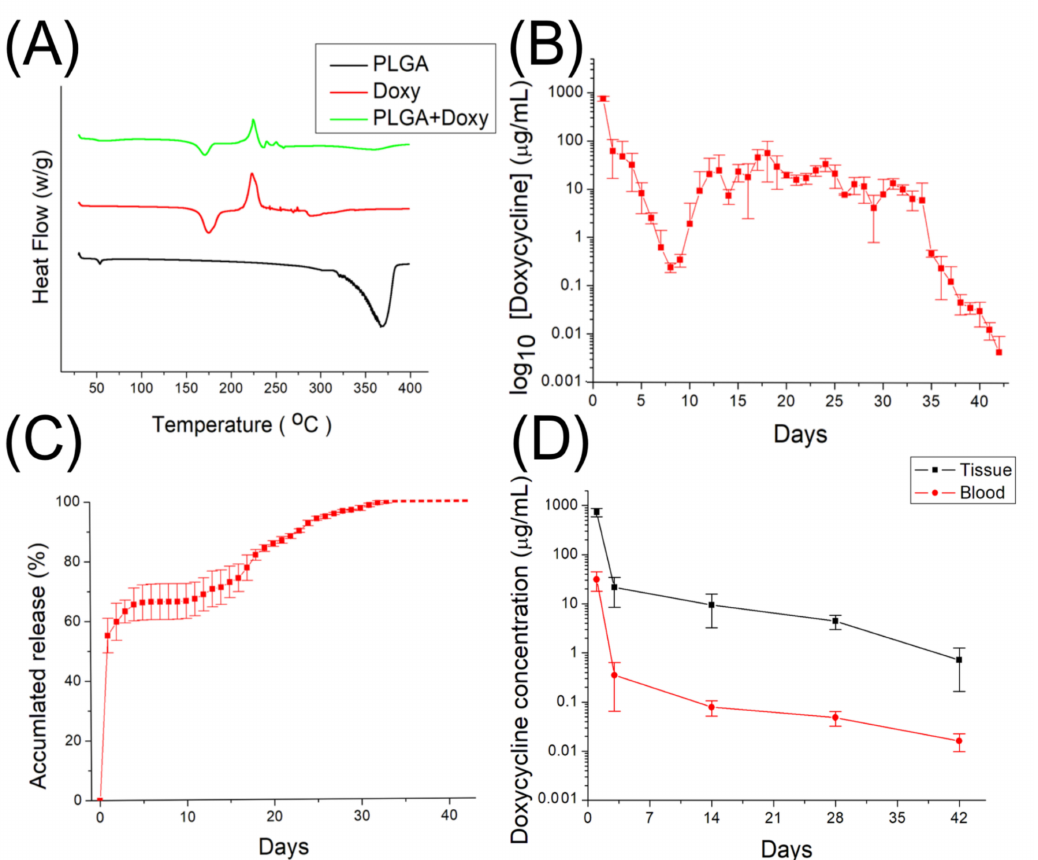
Figure 4. ( A ) Differential scanning calorimetry (DSC) assay of pure PLGA, doxycycline, and doxycycline-embedded, PLGA, nanofibrous membranes; ( B ) daily release, and ( C ) cumulative dis- charge of doxycycline in vitro from the nanofibers; ( D ) in vivo release of doxycycline in tissues and bloods over